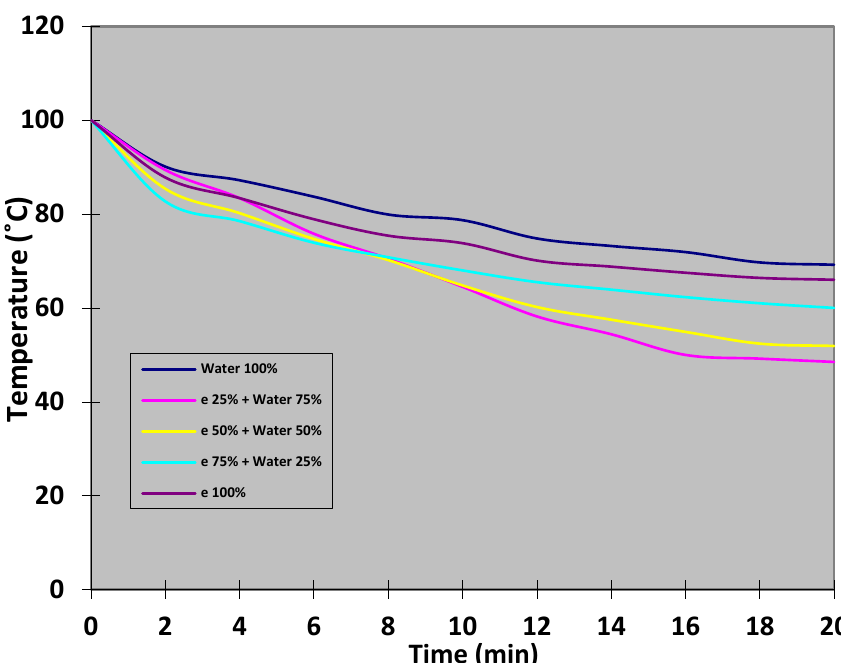
Figure 5. Surface temperature of the heater block for different liquid coolants at the 0.7 GPM flow rate.